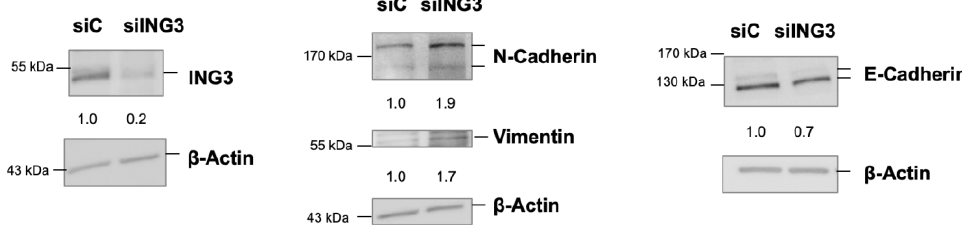
Figure 6. Knockdown of ING3 enhances the levels of EMT markers . Transient knockdown of ING3 by short interfering RNA (siING3) was used with scrambled siRNA as control (siC) to analyse key EMT markers by Western blotting.